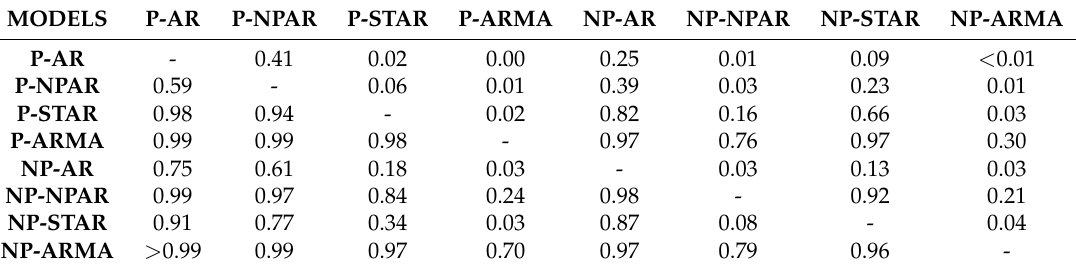
Table 4. P -values for the Diabold and Marion test for same forecasts accuracy against the alternative hypothesis that model in the column is more accurate than model in the row (using squared loss